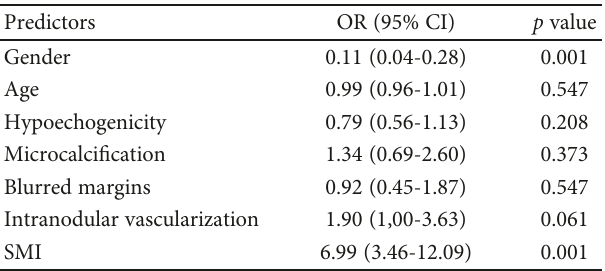
Table 4: Multivariate analysis of characteristics predicting the